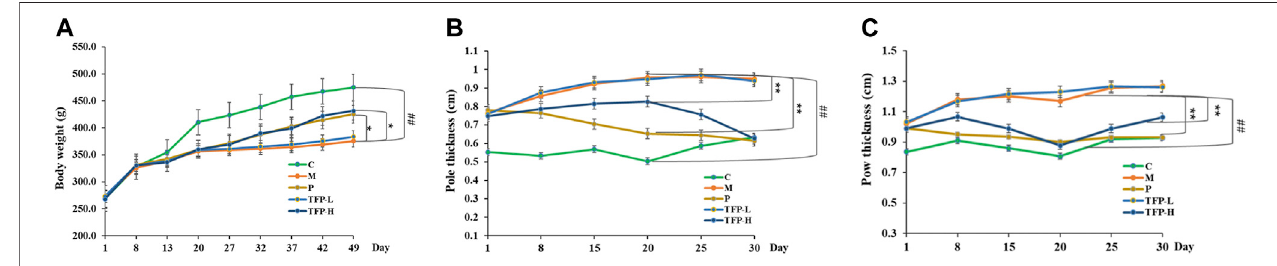
FIGURE 1 | (A) : Effect of TFP on the bodyweight; (B) : Effect of TFP on the ankle joint diameter; (C) : Effect of TFP on the sole thickness. ##: Signi fi cantly different compared with the Control group ( p < 0.01); *: Signi fi cantly different compared with the Model group, **: ( p < 0.01), *: ( p <